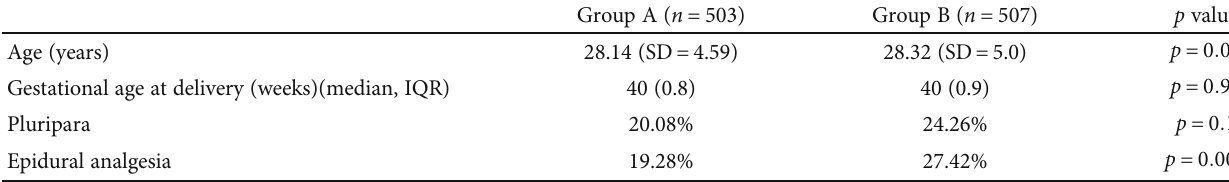
Table 1: Demographic characteristics of groups.